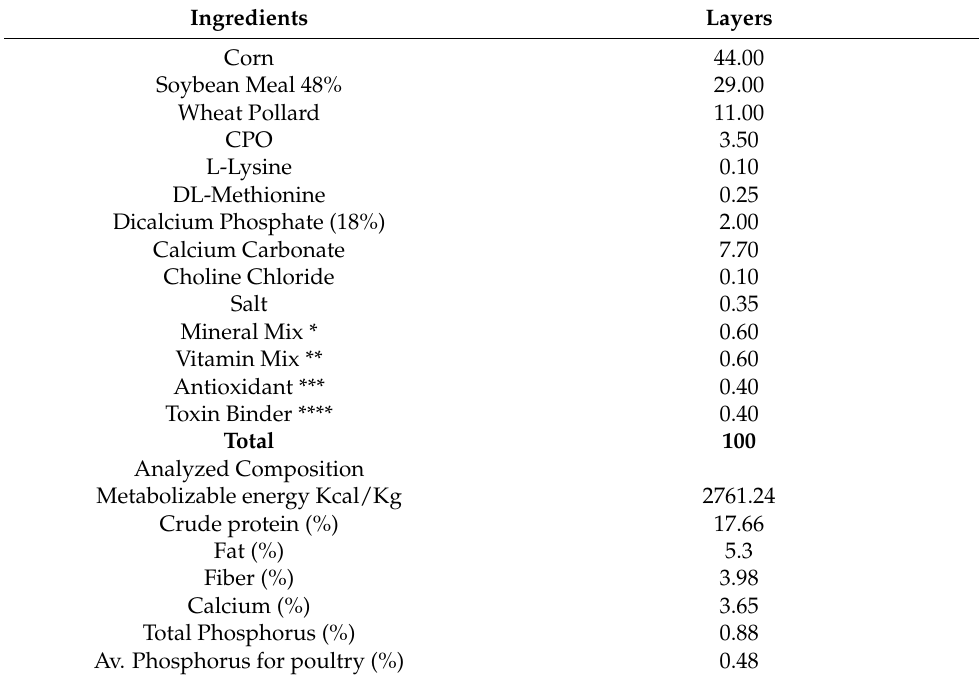
Table 1. Ingredient compositions and analyzed nutrient levels of the basal diet (on dry matter